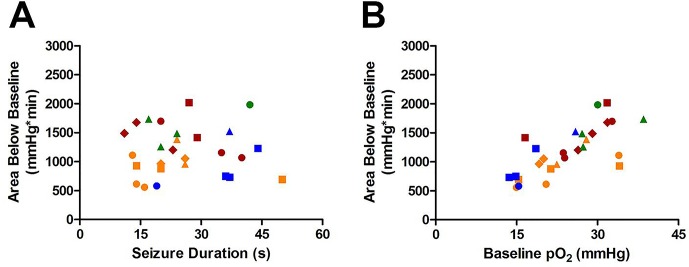
Susceptibility of Area Below Baseline analysis to changes in baseline pO2.(A) Seizure duration is not correlated with total area under curve (R square=0.000013, p=0.99). (B) Instead, the baseline pO2 is strongly correlated with the area below baseline (R square=0.52, ***p<0.0001).